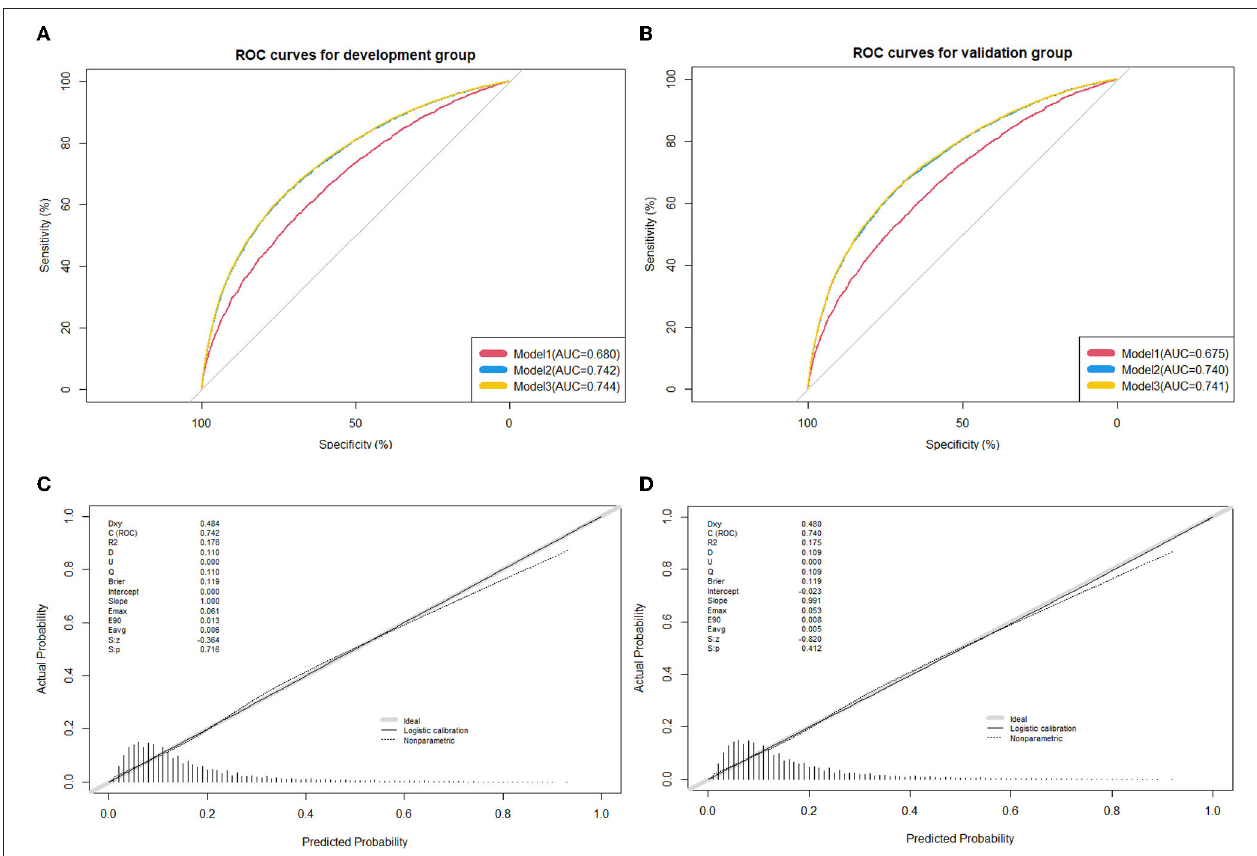
FIGURE 3 | Receiver operating characteristic (ROC) curves for the prediction of high blood pressure in the training group and validation group. (A) ROC curves of the factors and nomogram in the development group; (B) ROC curves of the factors and nomogram in the training group; (C) calibration plot of nomogram prediction in the development group; (D) calibration plot of nomogram prediction in the validation group. ROC curves from the prediction model and other predictive strategies (Model 1: Age, gender, gestational hypertension, weight status, family history of hypertension, family history of obesity, and average outdoor physical activity time; Model 2: Age, gender, gestational hypertension, weight status, family history of hypertension, family history of obesity, average outdoor physical activity time, birth weight, and feeding mode; and Model 3: Age, gender, gestational hypertension, weight status, family history of hypertension, family history of obesity, average outdoor physical activity time, birth weight, feeding mode, parental smoking status, parental education level, household monthly income, average screen-based time, and fried food intake) for comparison. The calibration curve represents the calibration of the nomogram, which shows the consistency between the predicted probability of conversion and actual conversion probability of HBP patients. The x-axis is the predicted probability by the nomogram and the y-axis is the actual conversion rate of HBP patients. The gray line represents a perfect prediction by an ideal model, and the black-dotted line shows the performance of the nomogram, of which a closer fit to the gray line means a better